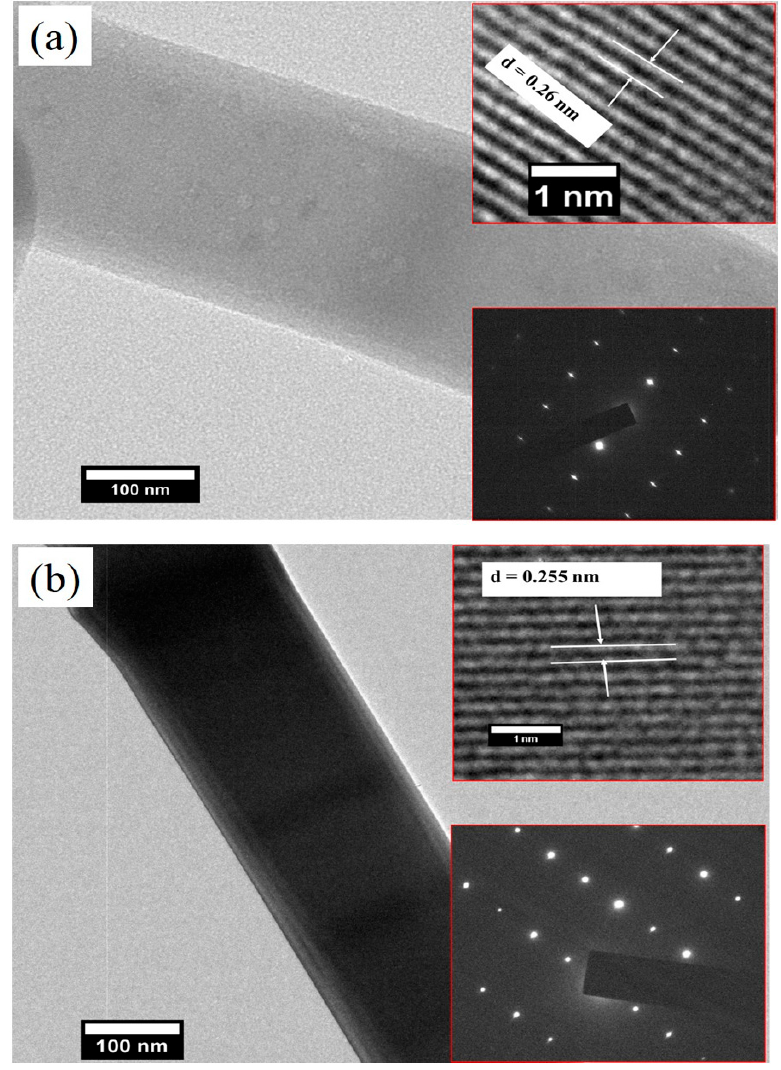
Figure 4. ( a , b ) TEM micrographs of pristine ZnO and Ar-ZnO nanowires. Inset shows the SAED pattern and HR-TEM image of pristine ZnO and Ar-ZnO nanowires.